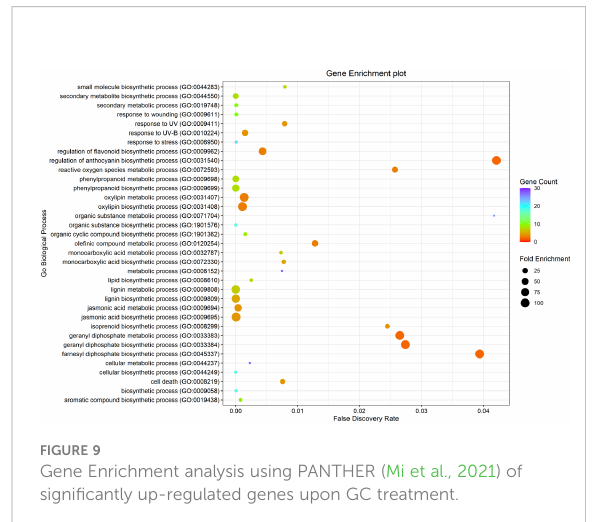
BA FIGURE 10 (A) HPLC Chromatograms of Piperine (343 nm, retention time 12.9 minutes) in detached P. nigrum leaves upon treatments. (a) Pn: Control P. nigrum , (b) PnPc: P. capsici infected P. nigrum , 24hpi, (c) PnGc: GC in fi ltrated P. nigrum , 24h, (d) PnGcPc: Gc in fi ltrated P. nigrum ,24h, infected with P. capsici , 24hpi (B) Concentrations of Piperine and Vanillic acid (ng/mg) in P. nigrum detached leaves after different treatments as revealed by LC/MS- MS analysis (Pn: P. nigrum control, PnPc: P. nigrum infected with P. capsici (24hpi), PnGc: Glycol chitosan in fi ltrated P. nigrum (24h), PnGcPc: P. nigrum infected with P. capsici 24h post in fi ltration with Glycol chitosan, 24hpi) (Schmittgen and Livak, 2008). One-way ANOVA was performed to compare signi fi cance among treatments. Values are means of triplicates. Data